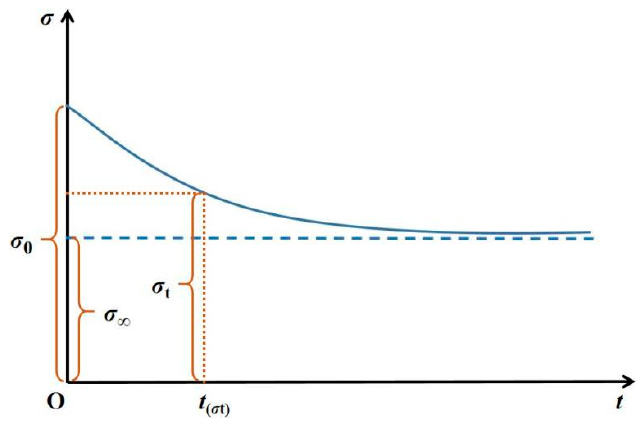
Figure 3 . Constitutive law for strength degradation of the micro element. Figure 3. Constitutive law for strength degradation of the micro